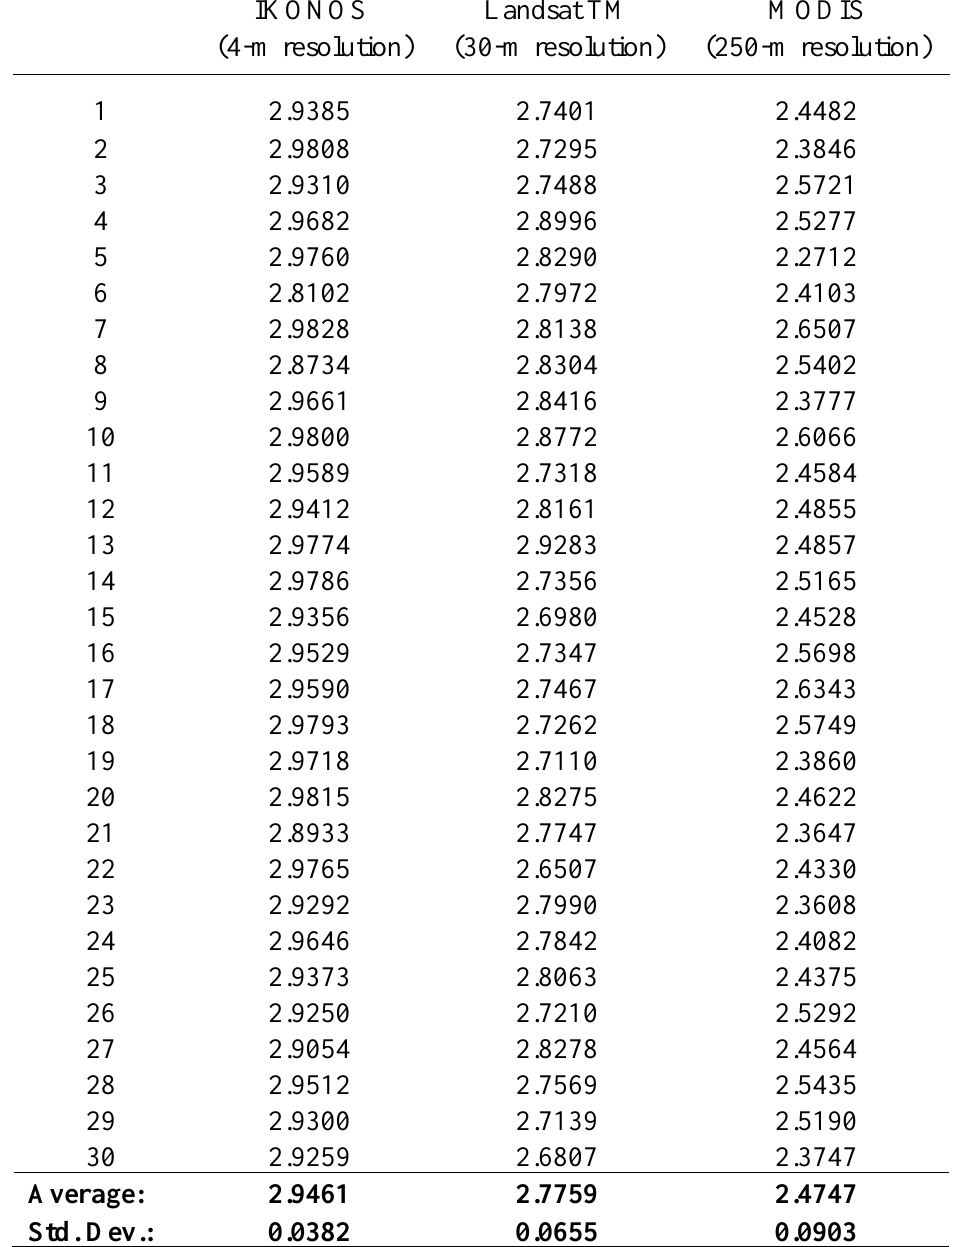
Table 4. Fractal dimension results of Guatemala study area for different resolution